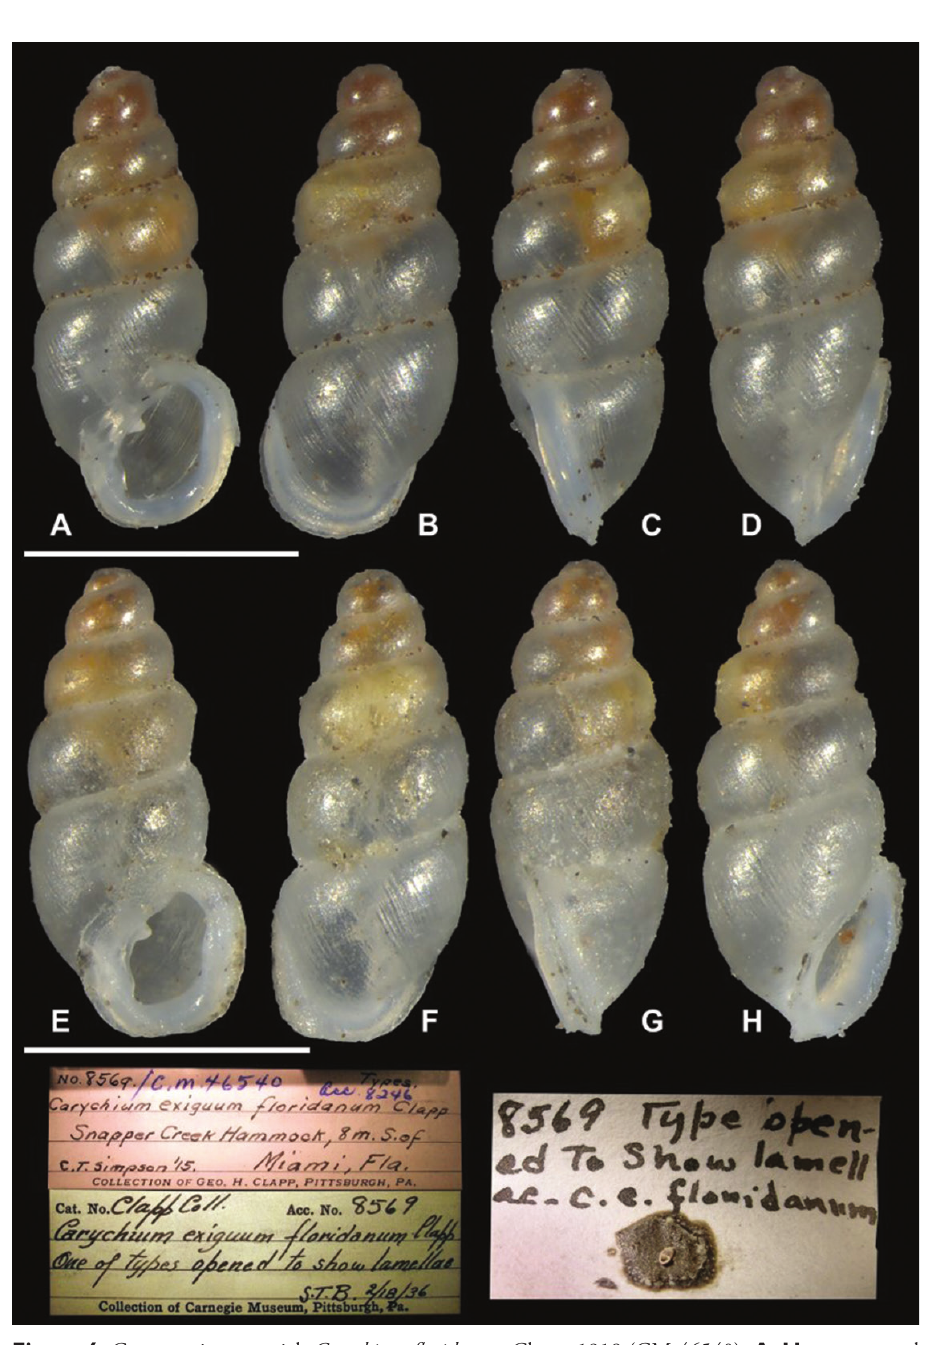
Figure 6. Comparative material, Carychium floridanum Clapp, 1918 (CM 46540). A–H syntypes and specimen information; E peristome with thick parieto-columellar callus and prominent parietal denticle. Scale bar 1